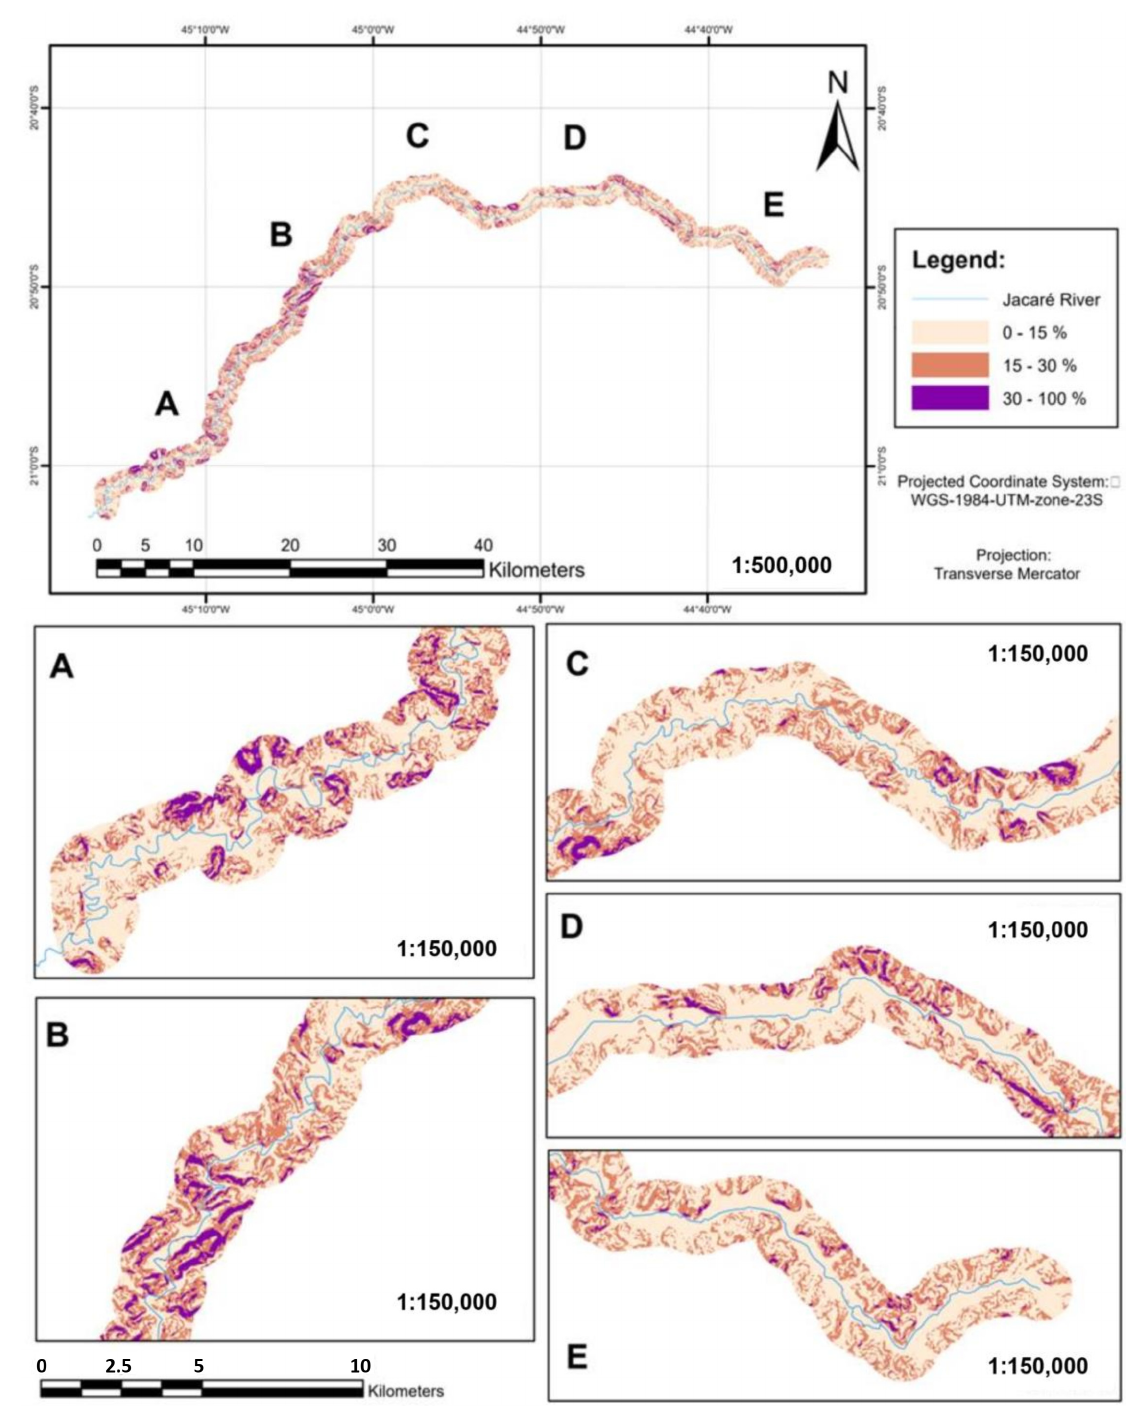
Figure 9. Slope map. ( A – E ) are the regions with the most significant potential for reforestation.